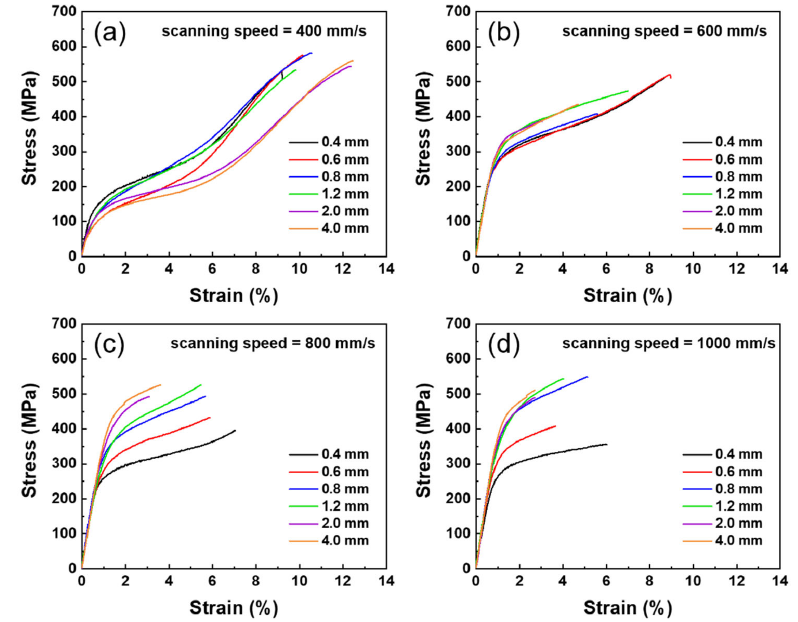
Figure 7. The stress–strain curves of the samples fabricated at different scanning speeds: ( a ) 400 mm/s, ( b ) 600 mm/s, ( c ) 800 mm/s, and ( d ) 1000 mm/s.